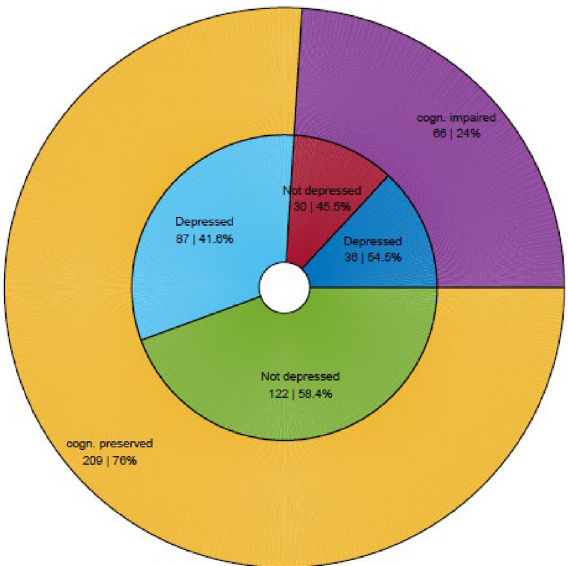
Figure 2. Presence of a positive screen for depression and cognitive impairment in the total population. The outer circle shows the proportion of cognitively impaired versus preserved patients, while the inner circle shows the proportion of depressed versus non-depressed patients in those two groups. Cogn. cognitively.